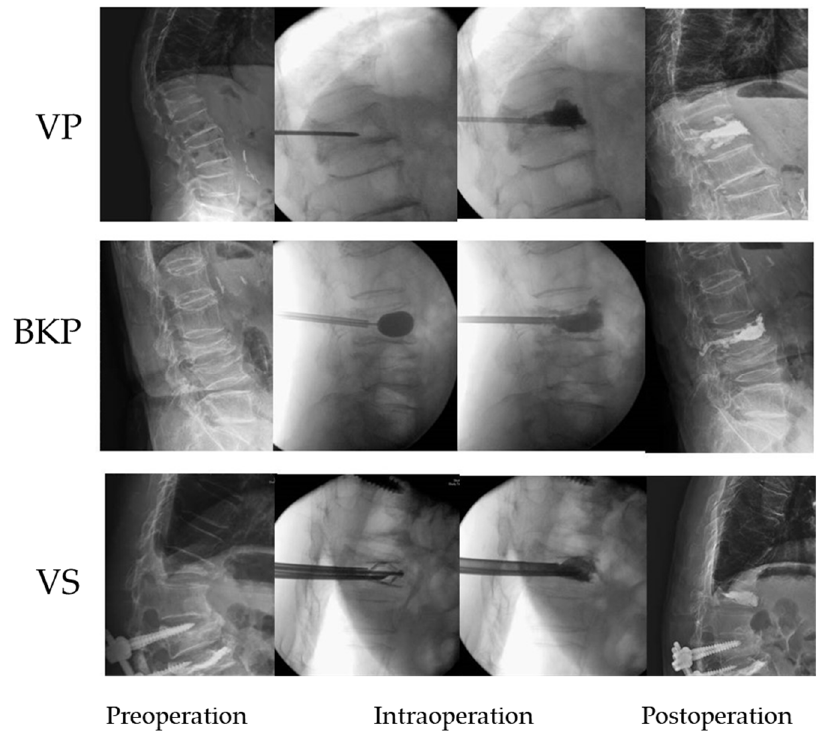
Figure 1. Radiographs representing three types of cement augmentation technique. VP: Vertebropalsty, BKP: Balloon kyphoplasty, VS: Vertebrae stent.